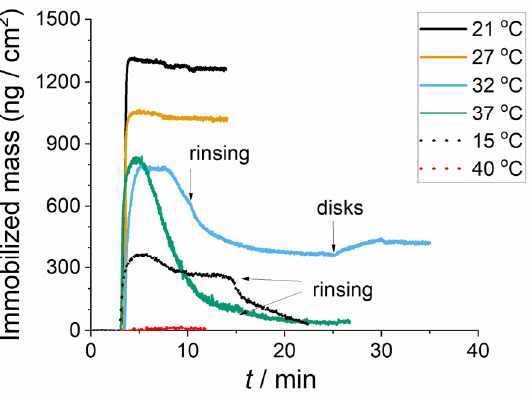
Figure 3. Mass density over time calculated upon the adhesion of DSPC:DSPE-PEG2000 80:20 lipodisks onto QCM-D silica sensors at different temperatures.